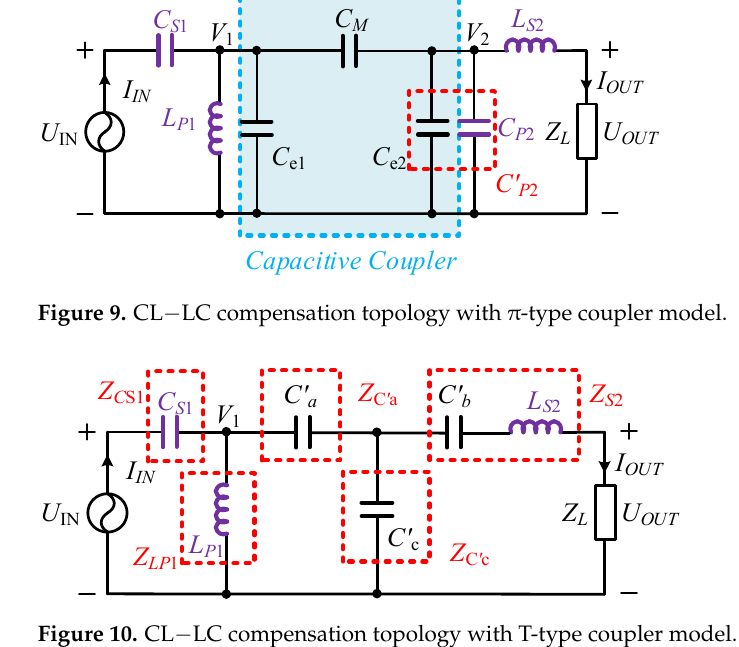
Figure 10. CL − LC compensation topology with T-type coupler model.